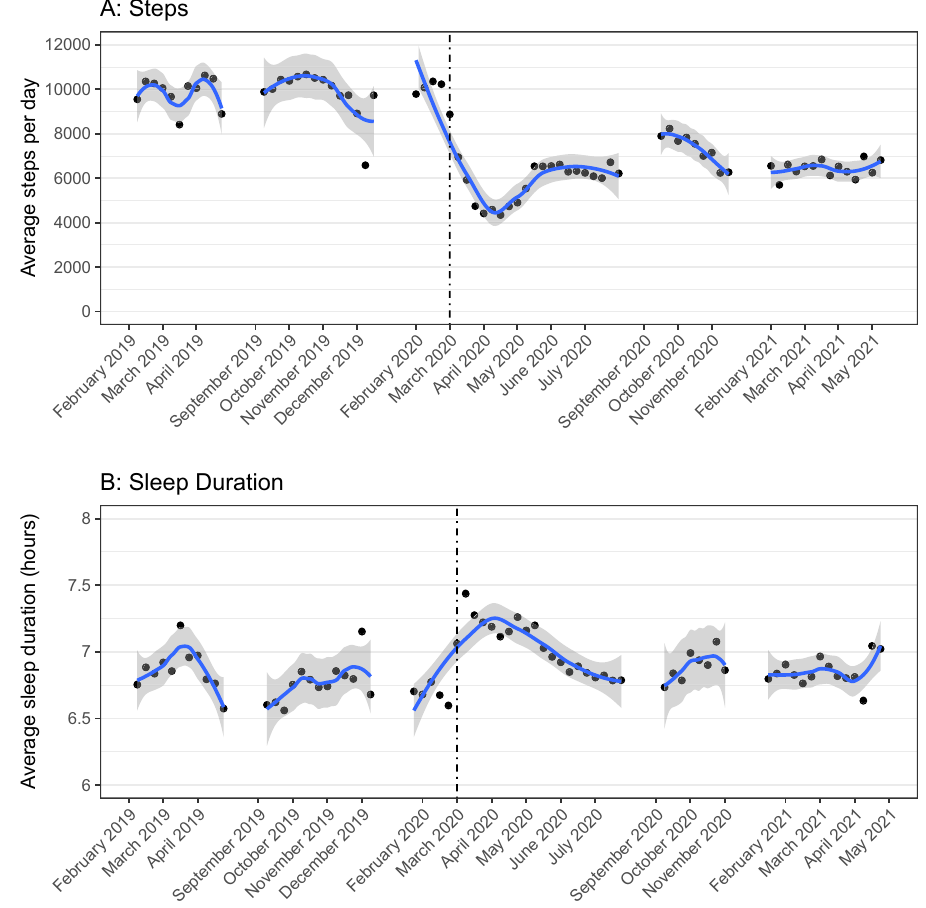
Figure 1. ( A , B ) The figure plots the average outcomes by week for study participants in the Spring 2019 through Spring 2021 cohorts for all participants with Fitbit data (n = 1150). Gray shading indicates 95% confidence intervals for the locally weighted smoothing curve. This figure was produced using R (version 3.6.1) https:// www.r- proje ct.